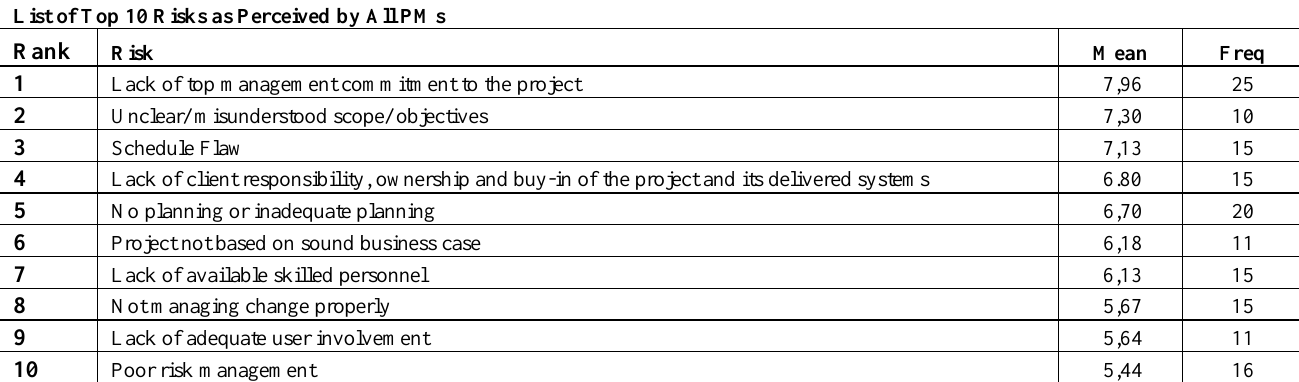
Table 2: Top Ten Risks as perceived by experienced PMs List of Top 10 Risks as Perceived by Experienced PM's